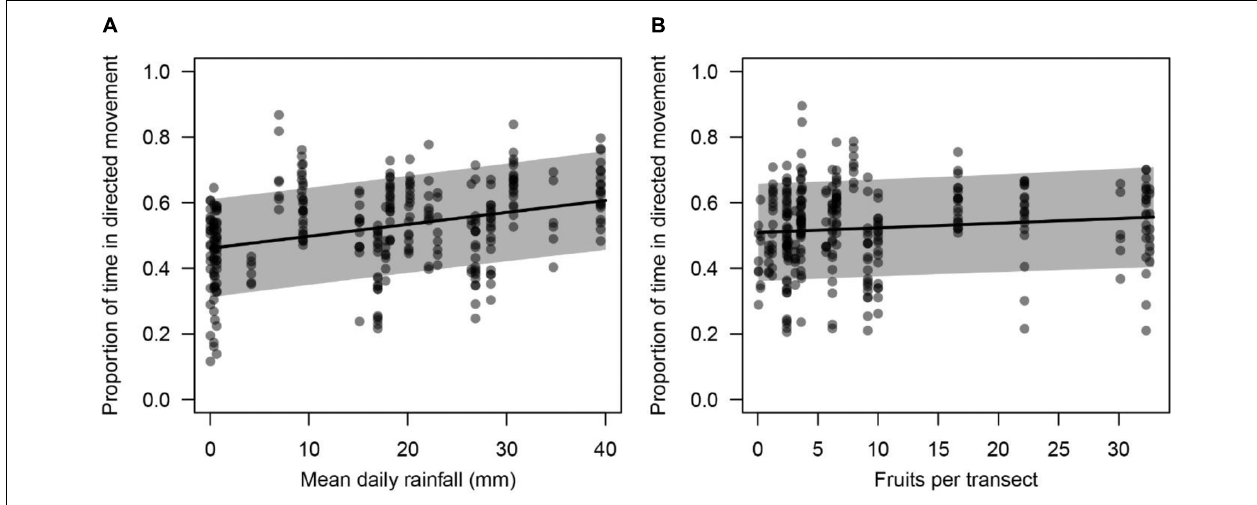
FIGURE 5 | Average relationship between directed movement and rainfall (A) and fruit abundance (B) at monthly scales. Where: black lines = population-average proportion of time in directed movement from the top model in Table 4 ; gray polygon = 95% confidence interval around the fixed effects; points = partial residuals from the best supported